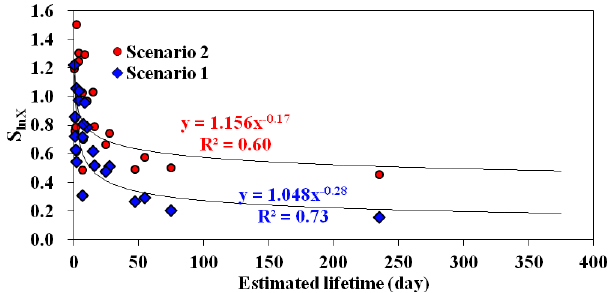
Fig. 6. The correlation of variability with lifetime for different VOC species with/without the influence of regional transport